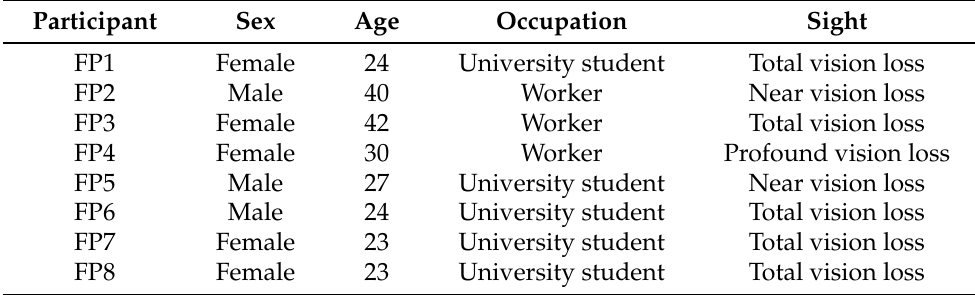
Table 2. Characteristics of blind and visually impaired participants in our formative study. Participant Sex Age